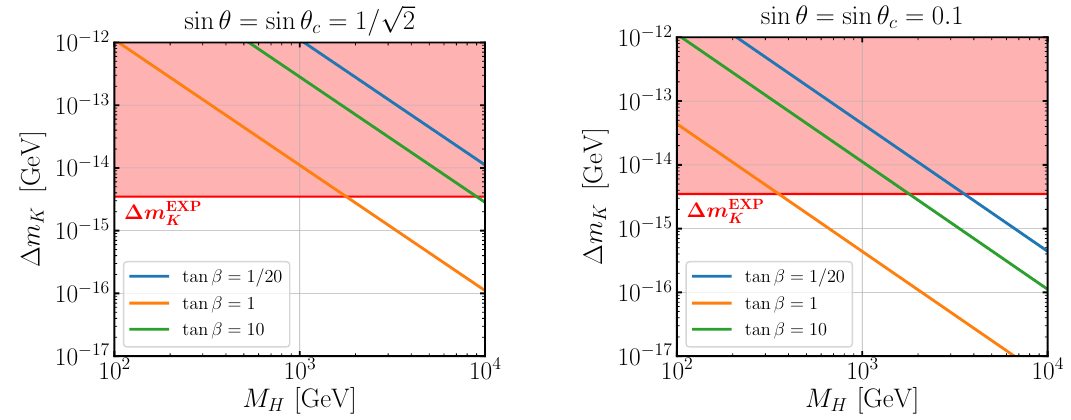
¯ K 0 mixing on the parameter space. We show the = M ; the lines H A . For the left (right) √ K = 1 / 2 ( sin θ = sin θ = 0 . 1 c c